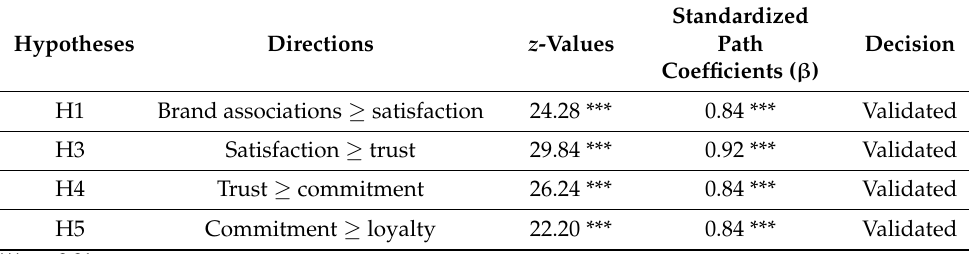
Table 4. Hypotheses testing in Rojas-M é ndez et al.’s (2009) model, which explains loyalty through the associations of brand ≥ satisfaction ≥ trust ≥ commitment ≥